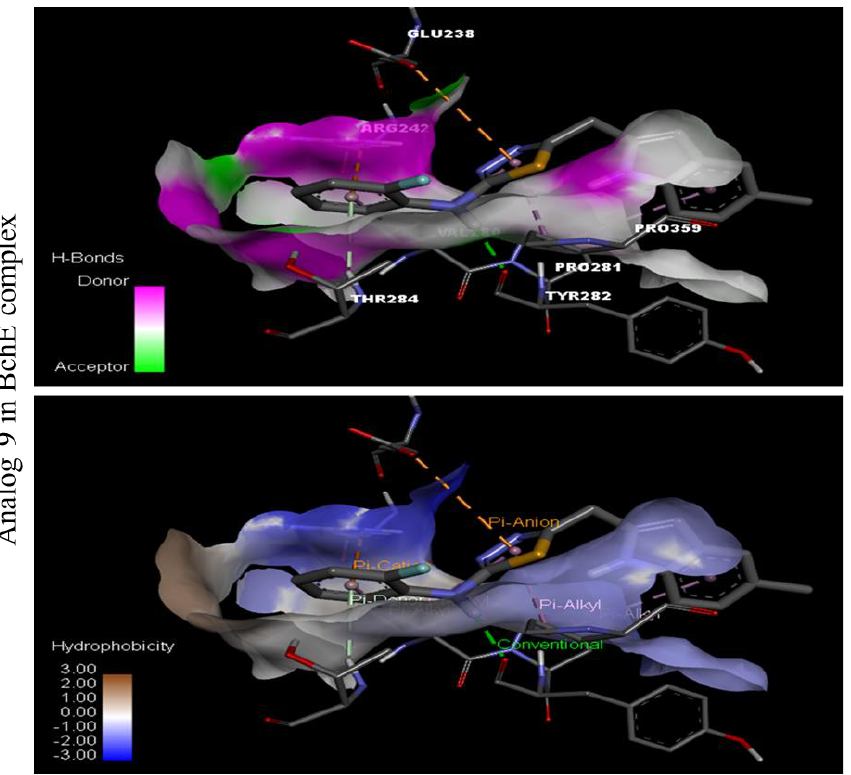
Figure 7. Indication of the hydrogen bond and hydrophobic nature against BuchE of compound 9.